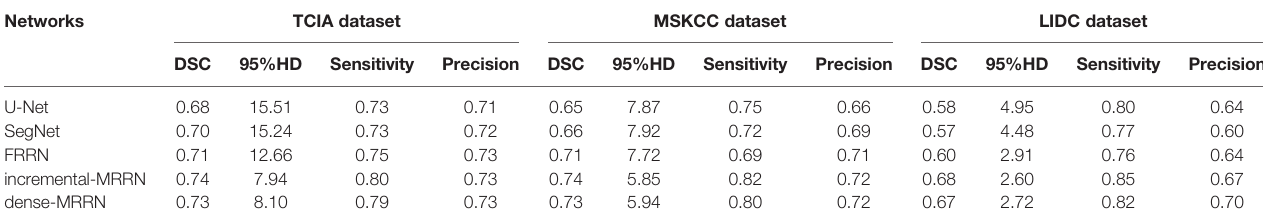
TABLE 7 | Comparison of different networks on segmentation of lung tumors in (41).